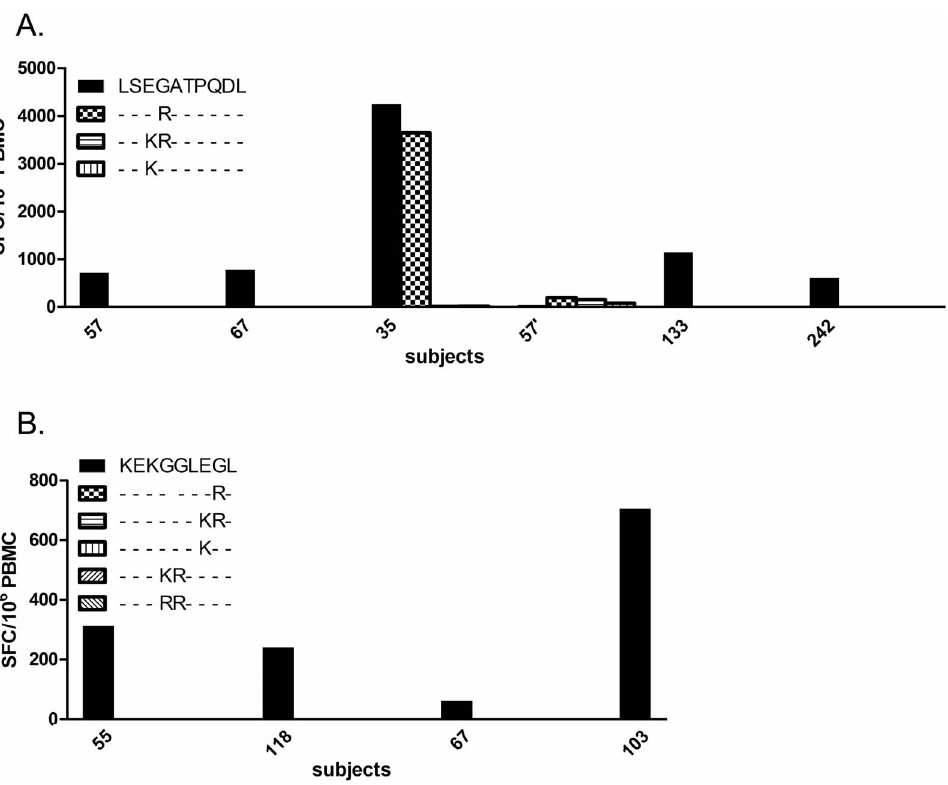
Figure 3. CD8 + T cell response to HLA-B44-restricted wild type and A3G/F-mutated epitopes. Responses of PBMC from HLA-matched subjects to wild type and mutant epitopes are shown on the Y-axis as IFN- c SFC/10 6 PBMC. A. Comparison of IFN- c induction between wild type and 3 mutant forms of the HLA-B44 restricted Gag epitope LSEGATPQDL. B. Comparison of IFN- c induction between wild type and 6 mutant forms of the HLA-B44 restricted Nef epitope KEKGGLEGL.